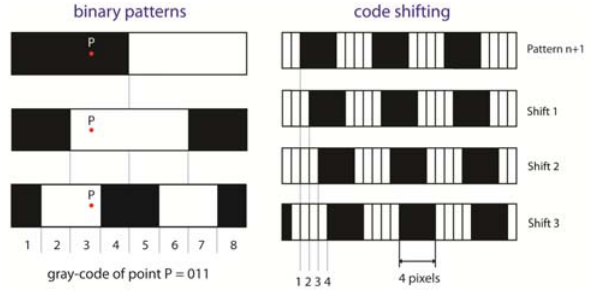
( left ) Example of three binary patterns with an associated 3-bit code that allows to distinguish 8 stripes; ( right ) examples of code shifting patterns.